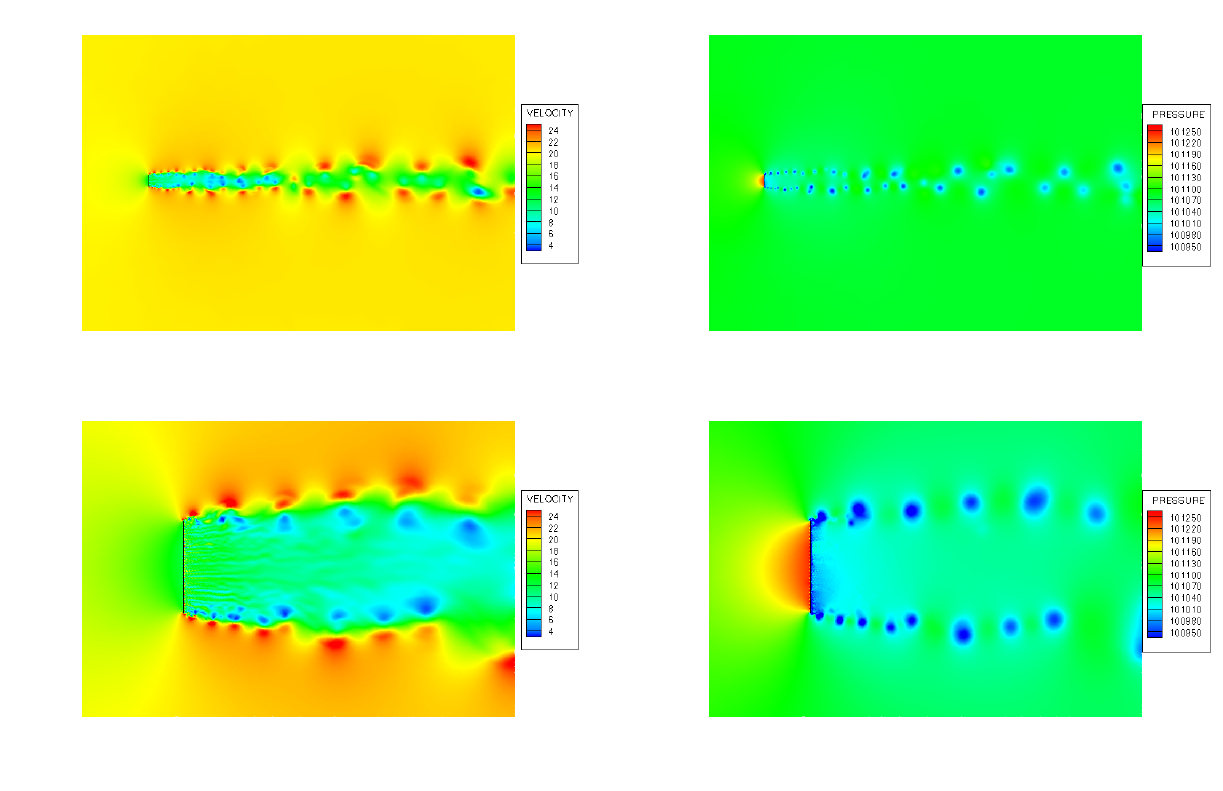
Fig. 6. The distribution of the pressure for the fence for 20 ms − 1 .